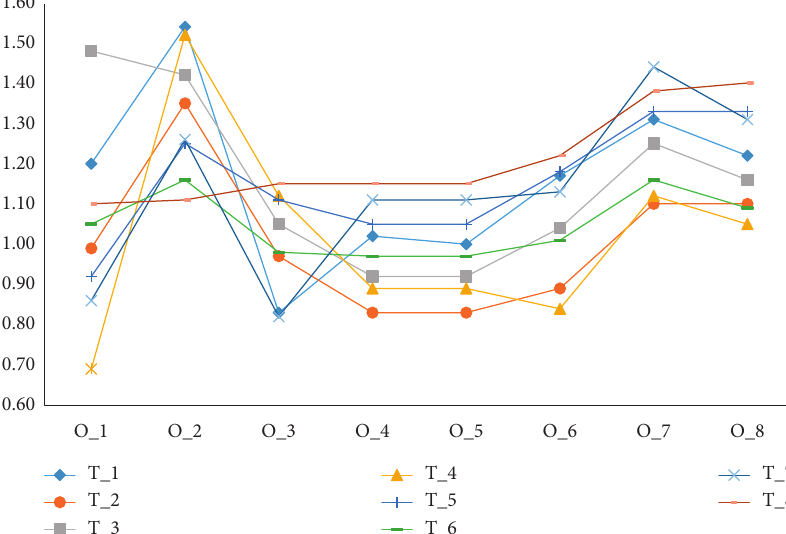
Figure 8: Comprehensive matching degree of each subtask of each team.